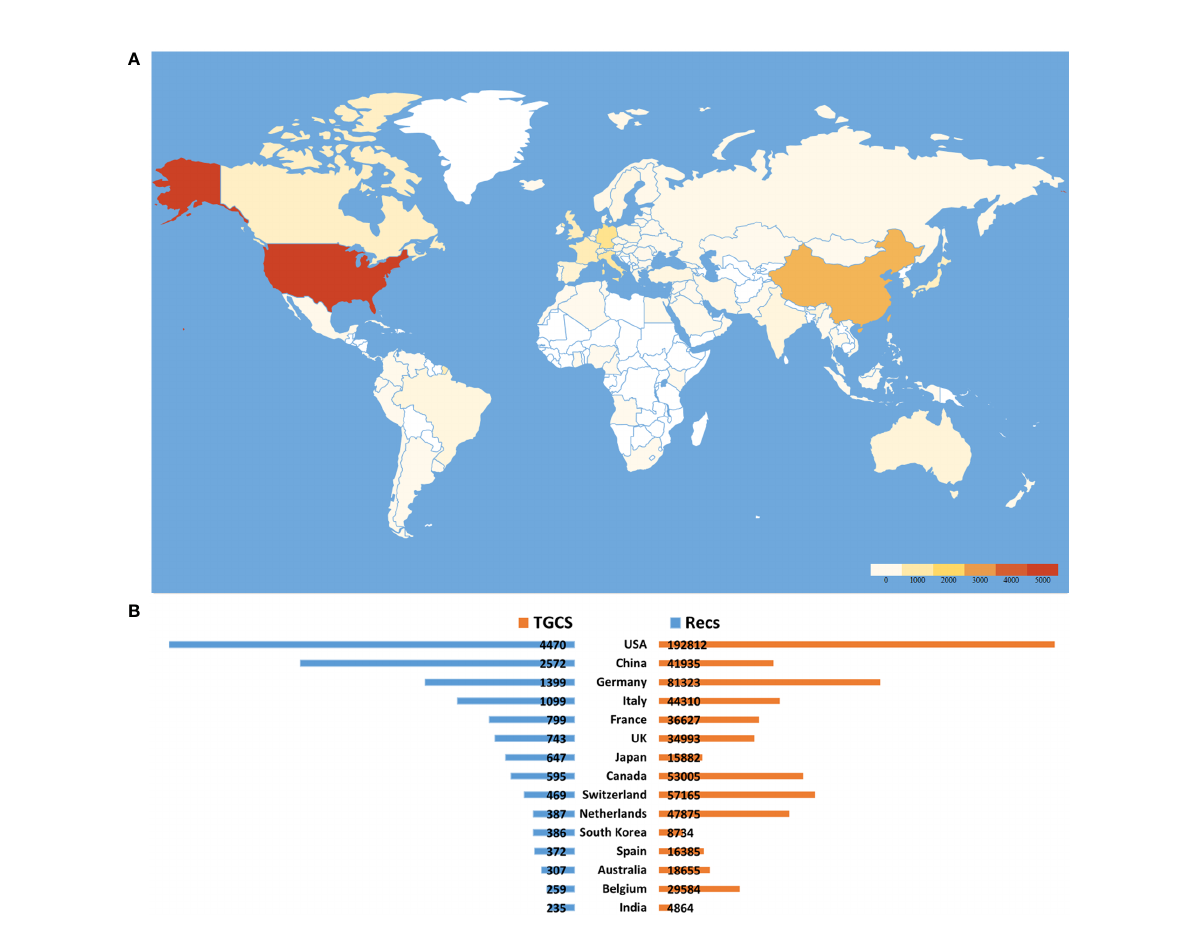
FIGURE 4 Main countries distribution on TMZ publications. (A) Geographical distribution of TMZ. (B) The top 15 most productive countries in the publication of TMZ and their corresponding